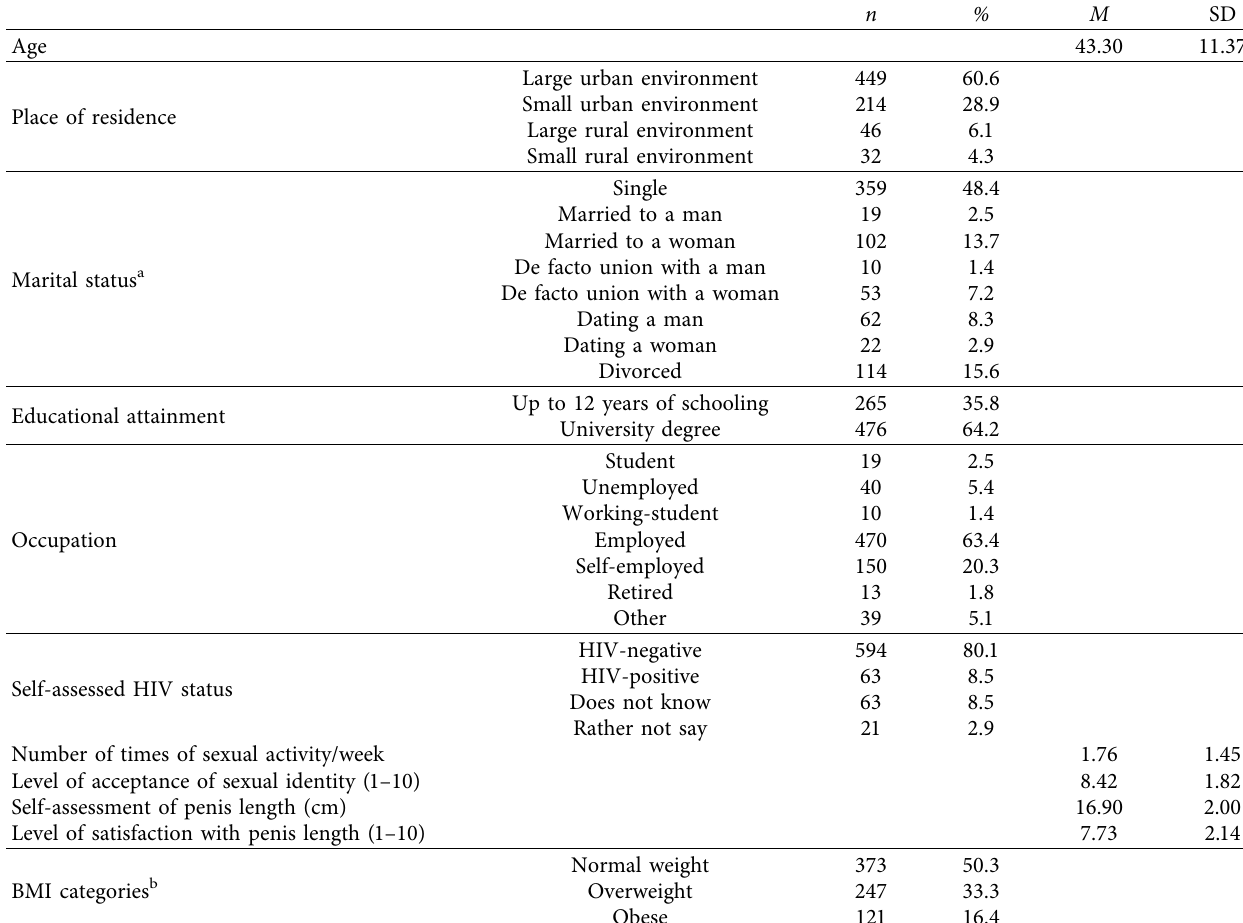
Table 1: Sociodemographic characteristics of the sample participants ( n �